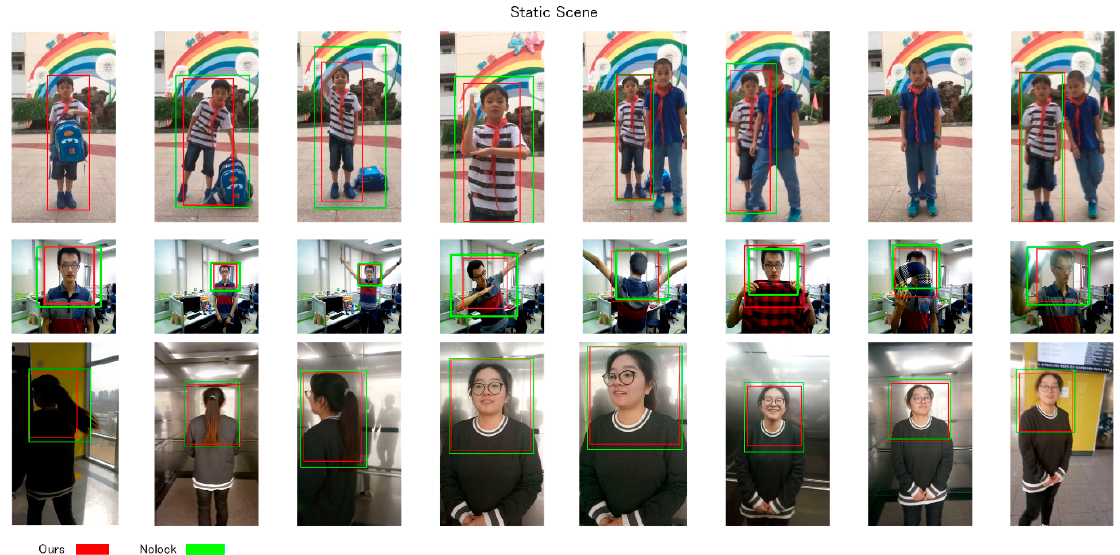
Figure 8. Image sequences for the static view. Table 2. Comparison of our approach with and without classification-lock